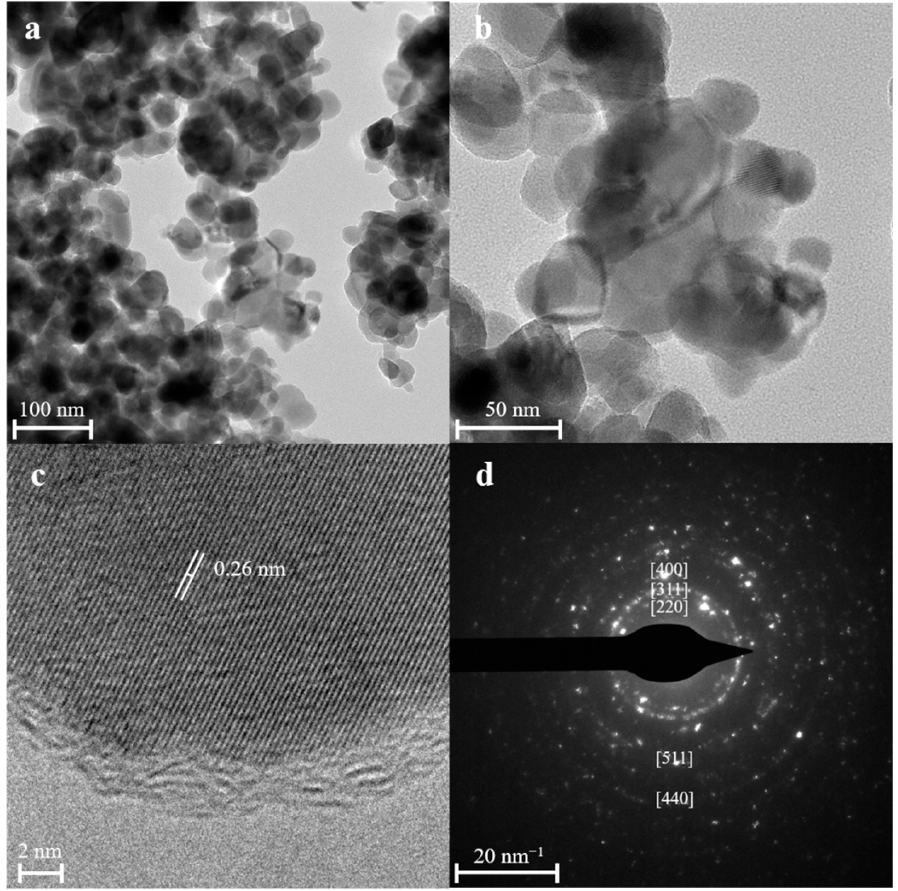
Figure 2. ( a – c ) The HRTEM graphs of the Fe 3 O 4 @C, and ( d ) the SAED micrograph of the Fe 3 O 4 @C.